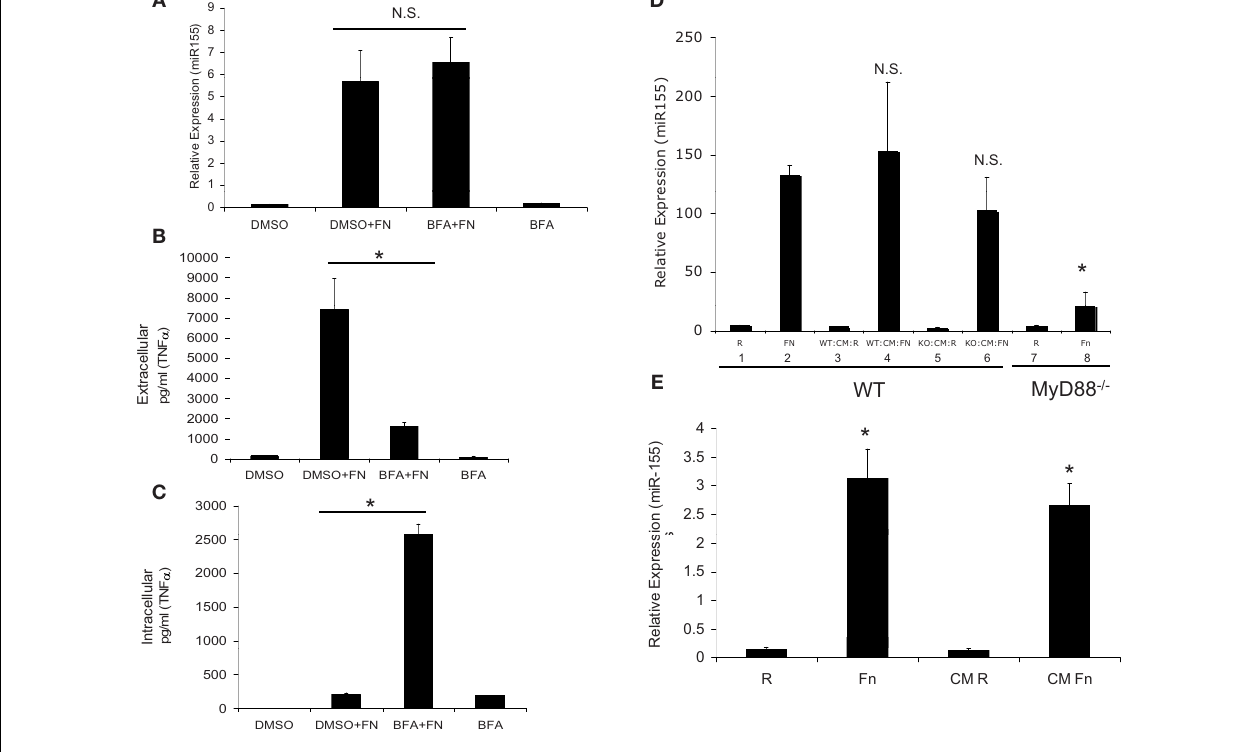
FIGURE 4 | MiR-155 induction is not mediated through host cytokines, but rather by soluble bacterial factors. (A) PBM were infected with F.n. at an MOI of 50 for 16h in the presence of Brefeldin A (BFA) or DMSO vehicle control. RNA was isolated and mature miR-155 expression was assayed by qRT-PCR. (B) ExtracellularTNF α levels were measured by ELISA. (C) IntracellularTNF α levels were measured by ELISA from the cell lysate. (D) WT and MyD88 − / − BMMs were infected for 24h at an MOI of 50 and then sterile filtered to remove bacteria to generate conditioned media (CM). RNA was collected from the infected cells for qRT-PCR (Bars 1, 2, 7, 8).The conditioned media was then placed on new wild-type BMM for 24h and RNA